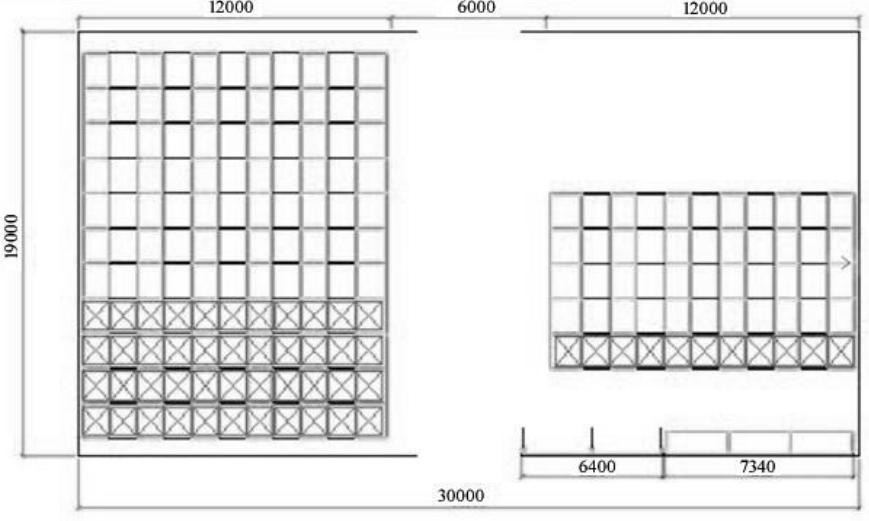
Figure 9. Close-packed shelves.